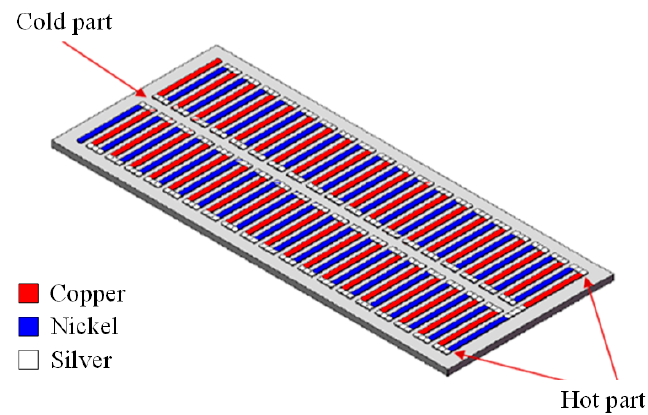
Figure 1. Schematic structure of the flexible thermoelectric generator.